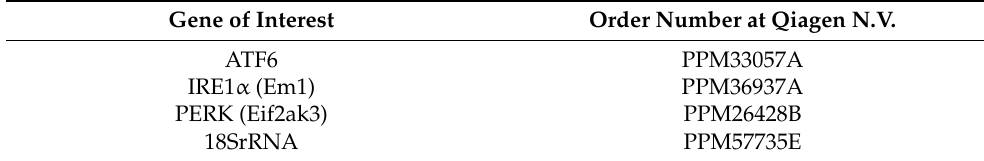
Table 4. Primer purchasing detail. Gene of Interest Order Number at Qiagen